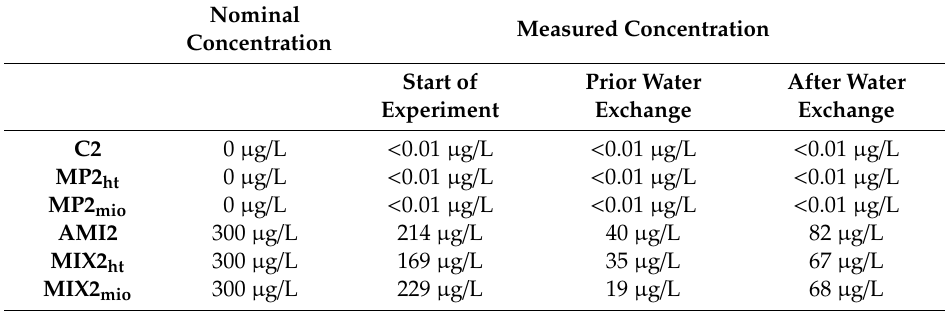
Table 3. Nominal and measured amitriptyline concentrations at the start of the experiment as well as prior and after a water exchange.